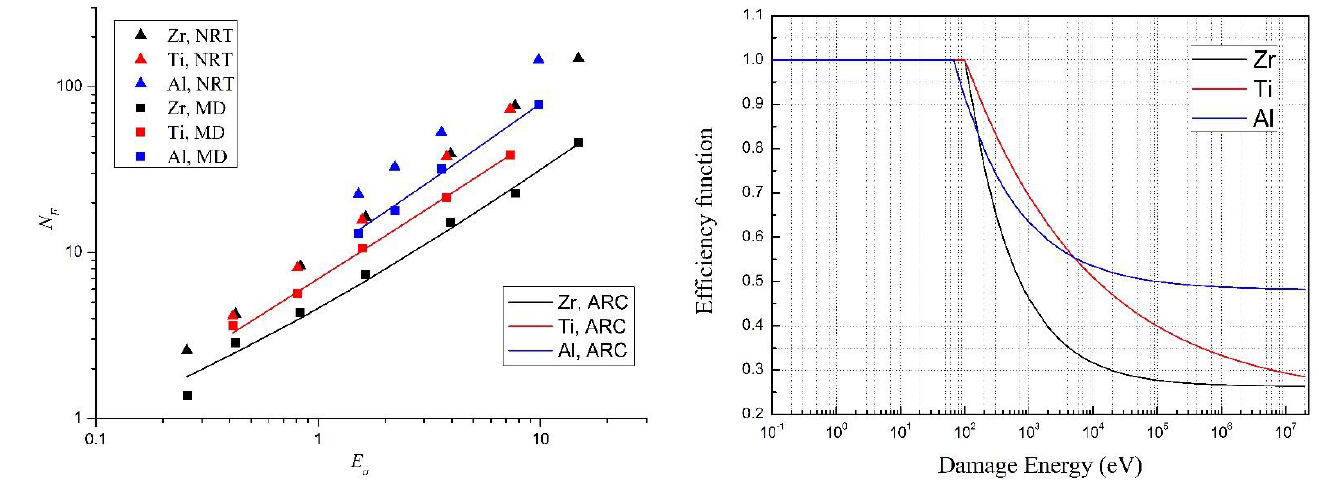
Figure 2. Number of defects atoms comparison Figure 3. Efficiency function for Zr, Ti and